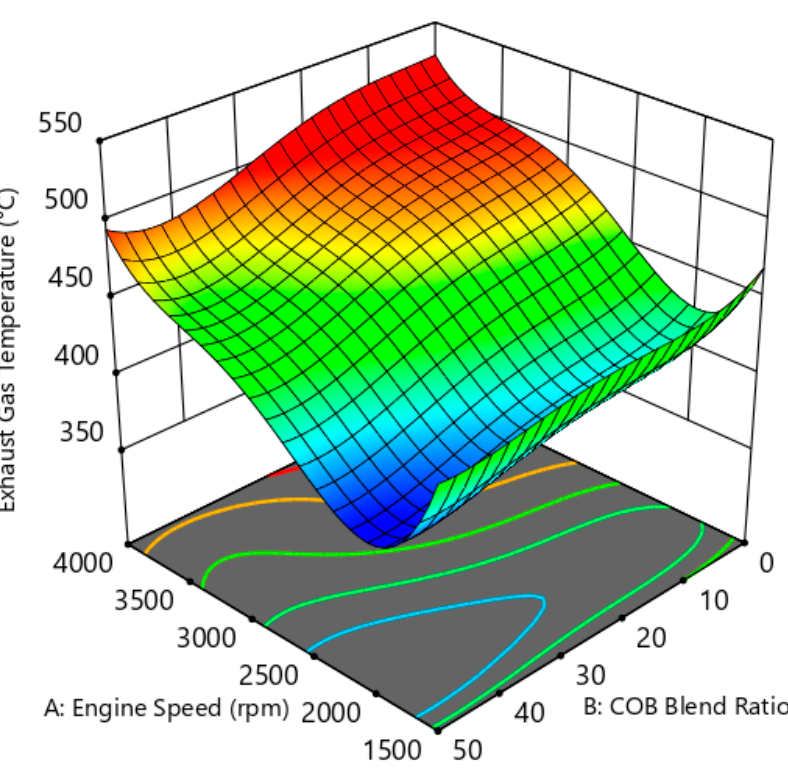
Figure 10. Exhaust gas temperature (EGT) versus engine speed for all test fuels.